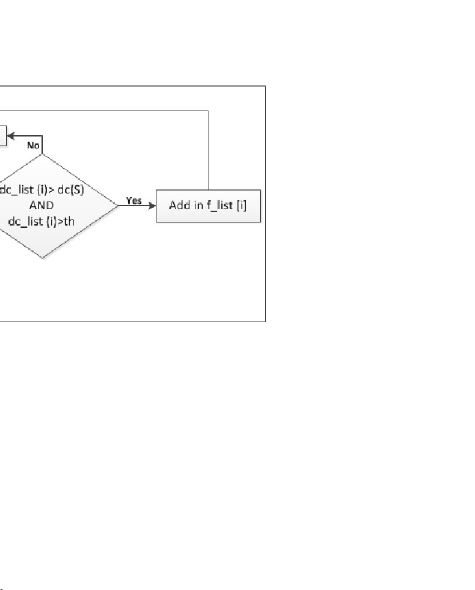
Fig 3. Operation flow of SAAD routing scheme.